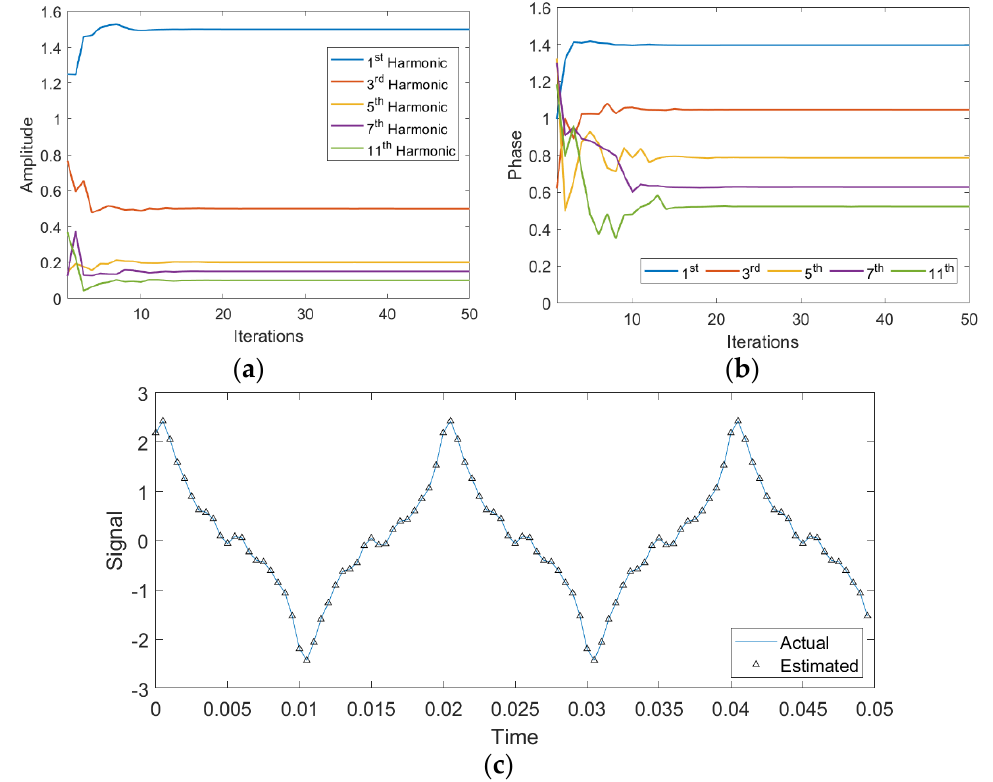
Figure 5. Plots of parameters estimates for 0.1 λ and 70 dB δ . ( a ) amplitude ( b ) phase ( c ) curve-fitting.